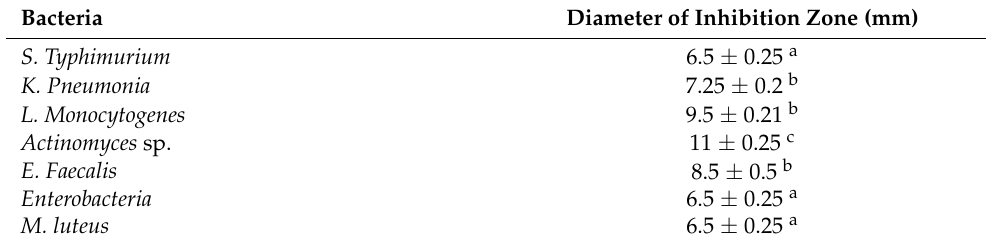
Table 1. Antibacterial power of the tested alga against seven bacteria.